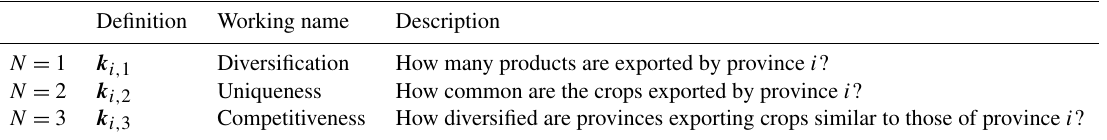
Table 1. Interpretations of the first three pairs of variables describing the province–crop network through the method of reflections.